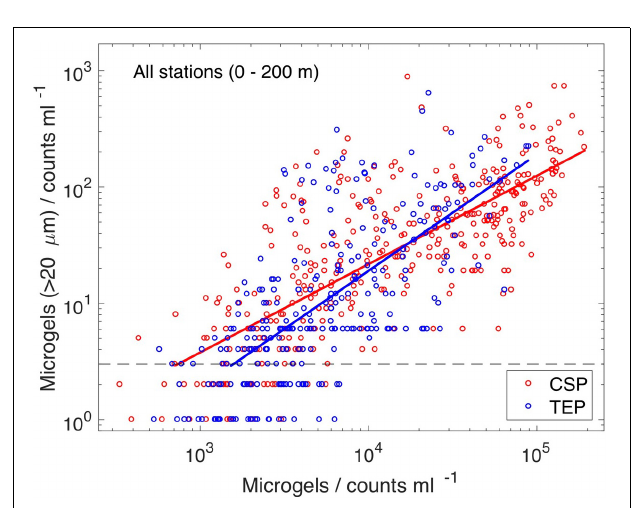
FIGURE 4 | The abundance of microgels with ESD > 20 µ m increased with the number of total abundance of microgels (Pearson correlation coefficients, ρ ρ TEP = 0.71). The lines are best estimates (root mean square CSP = 0.76 and minimizations on logarithmic scale), assuming a linear relationship between log-transformed values of microgel abundance with ESD > 20 µ m and total abundance ( (cid:54) ): f CSP = 0.76 · [log 10 ( (cid:54) CSP ) – 2.24] (red line), and f TEP = 1.0 · [log 10 ( (cid:54) TEP ) – 2.72] (blue